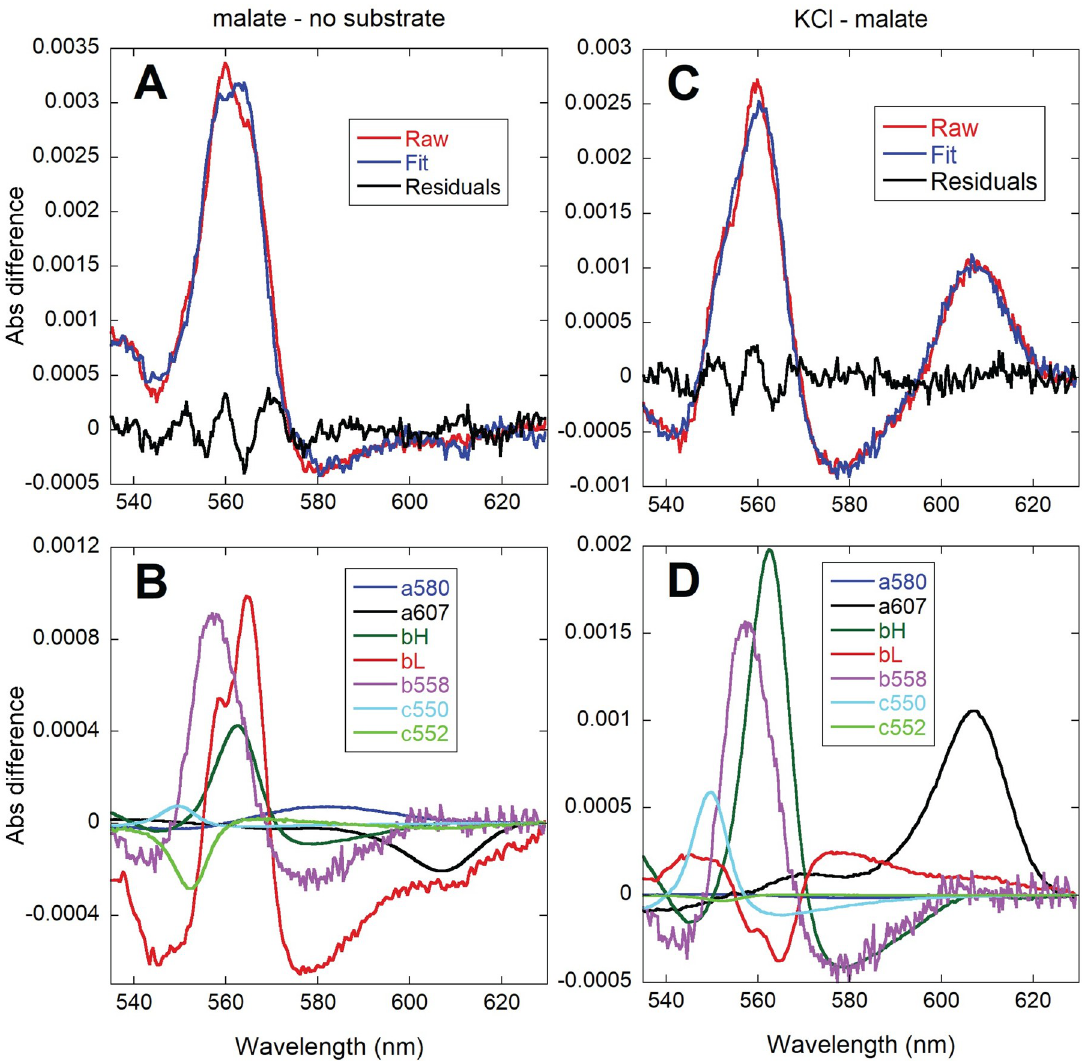
Fig 8. Comparison of the absorbance changes induced by the addition of 16.5 mM sodium malate (left, A and B) and 20 mM KCl after malate (right, C and D). Difference spectra of 8.4 x 10 9 /ml CyoB - /CcoN - K + depleted cells were calculated relative to incubation without substrate (left) or relative to the steady state after malate addition (right). 200 spectra collected every 0.5 s were averaged for each condition and the resulting averaged spectra were subtracted as indicated (malate-substrate or KCl-malate). The top panels (A and C) show the fit (blue) of the raw spectral data (red) and the residuals of the fit (green). The bottom (B and D) panels show the contribution of each cytochrome reference to the fitted spectra.